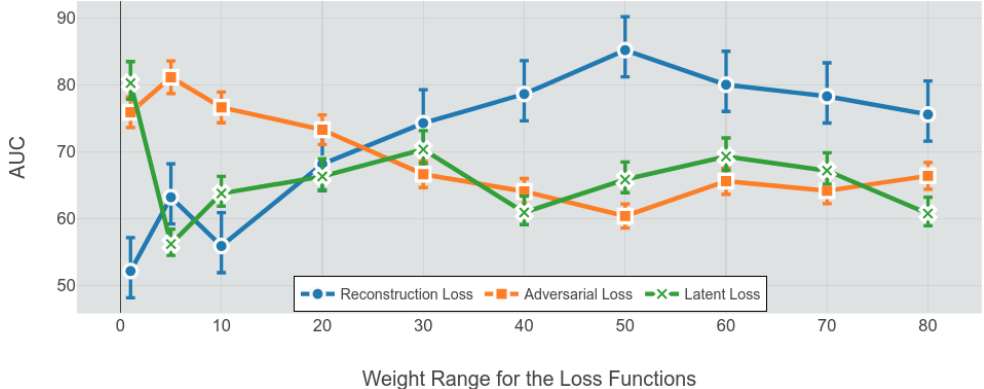
Figure 2. Loss function range search results for reconstruction loss, adversarial loss, and the latent loss. The model shows optimal performance with the parameters λ context = 50, λ adv = 5, and λ latent = 1. The most important weighting parameter is found to be the λ context